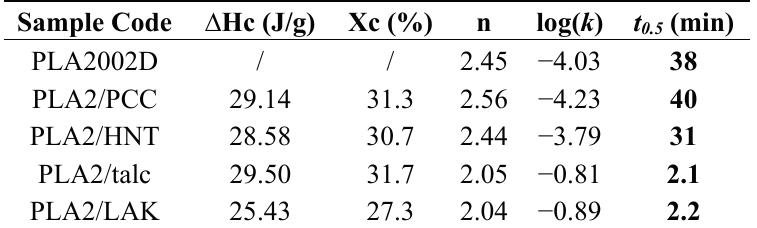
Table 1. Comparison of the isothermal parameters of PLA 2002D binary composites with different fillers.